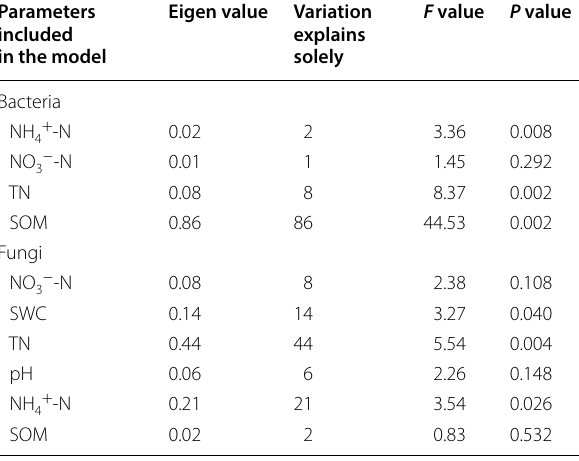
axes for community composition explained 63.9% and